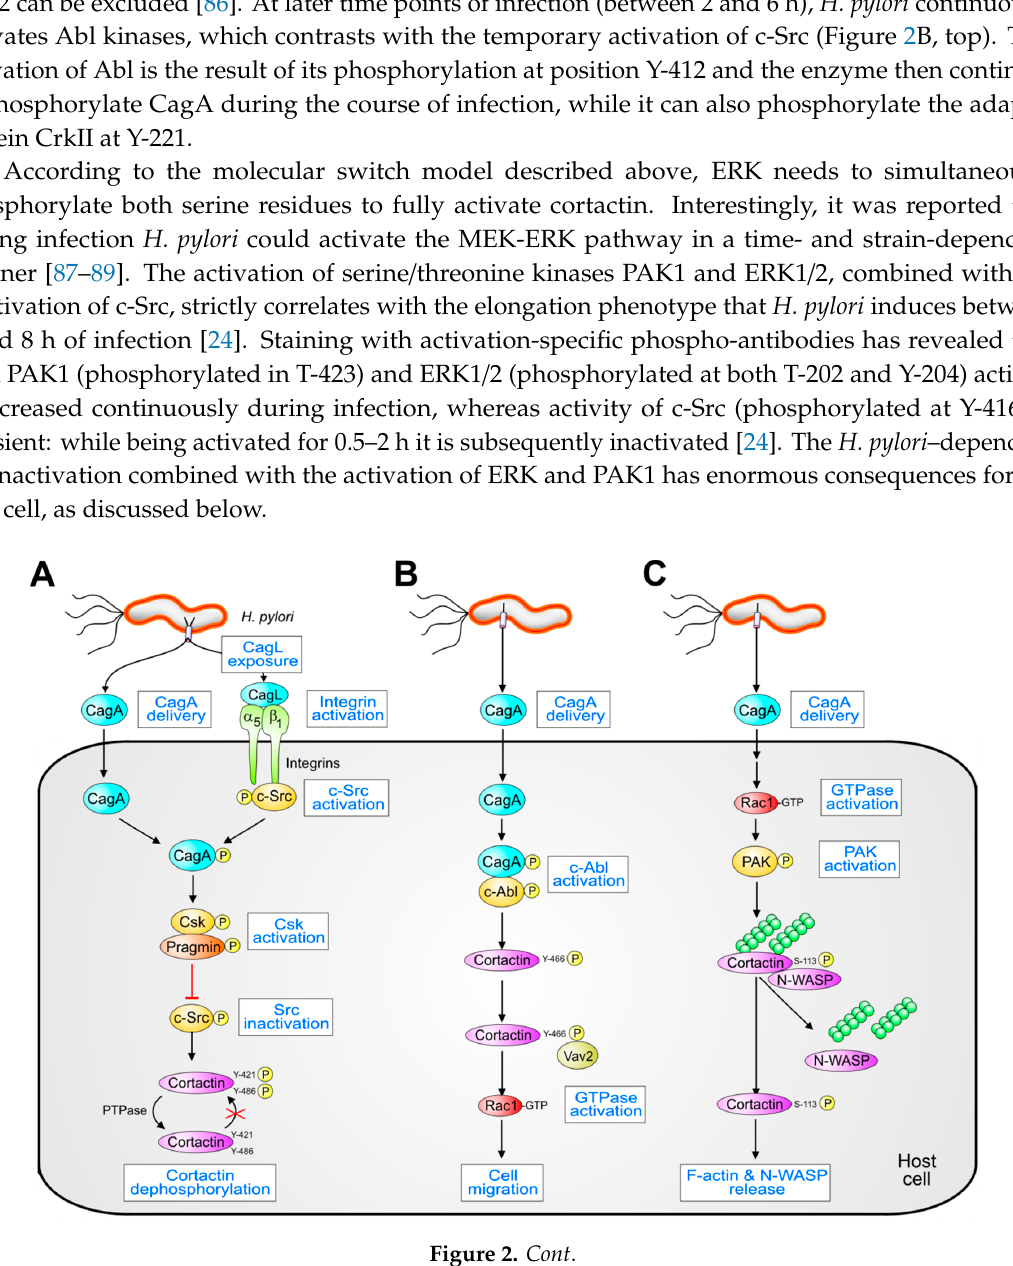
Figure 2. Schematic overview of molecular H. pylori signaling pathways that involve cortactin during infection of gastric epithelial cells. ( A ) The H. pylori T4SS pilus protein CagL activates c-Src tyrosine kinase through α 5 β 1 -integrin interaction [90]. Activated c-Src phosphorylates injected CagA, which in turn leads to the activation of Csk, a c-Src inhibitor [24,85]. Csk in complex with pragmin, a protein which potentiates kinase activity of Csk, inactivate c-Src that further results in tyrosine dephosphorylation of cortactin at Y-421 and Y-486 [91]. ( B ) The H. pylori protein CagA after injection into a host cell by the T4SS machinery activates tyrosine kinase c-Abl, which phosphorylates cortactin at Y-466 [92,93]. The downstream signaling leads to the recruitment of the Rho-family guanine nucleotide exchange factor Vav2 by phosphorylated cortactin, finally resulting in Rac1-mediated cell movement [94]. ( C ) Alternatively, CagA-activated Rac1 can lead to the activation of the serine-